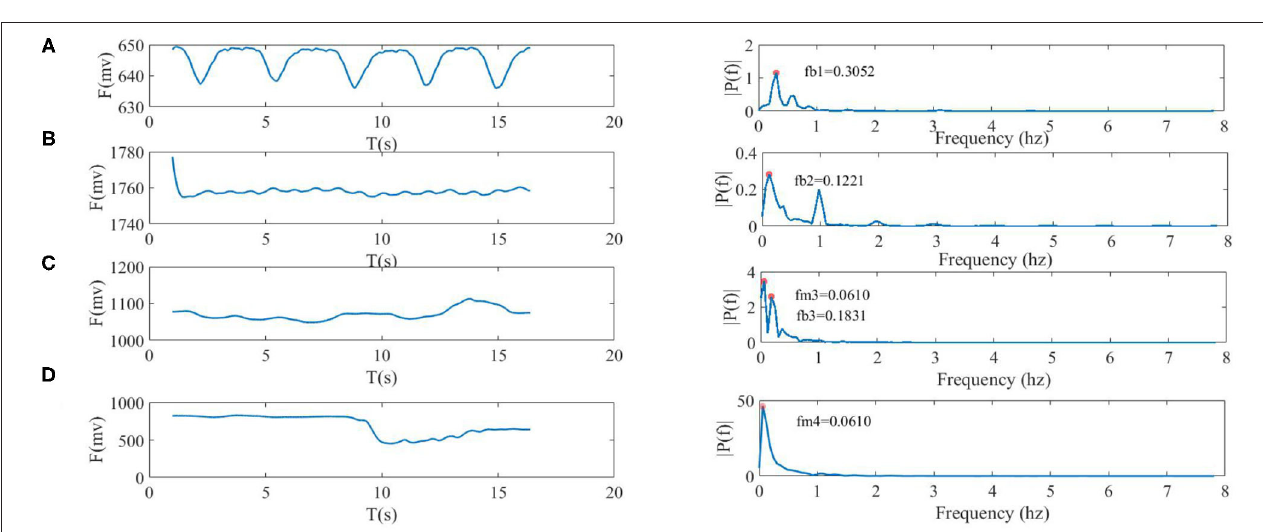
FIGURE 7 | Response relationship between amplitude frequency and phase frequency of 9-25Hz six-order FIR Filter.